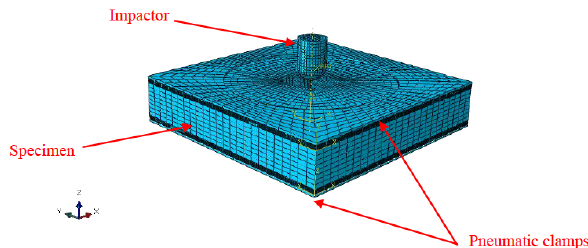
Figure 4: The FE model of the low velocity impact